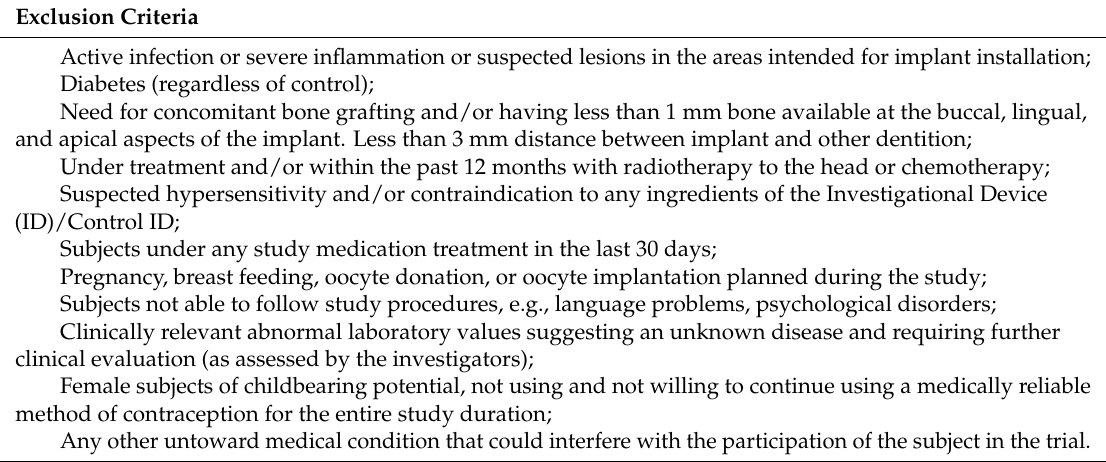
Table 6. Criteria for exclusion from the clinical